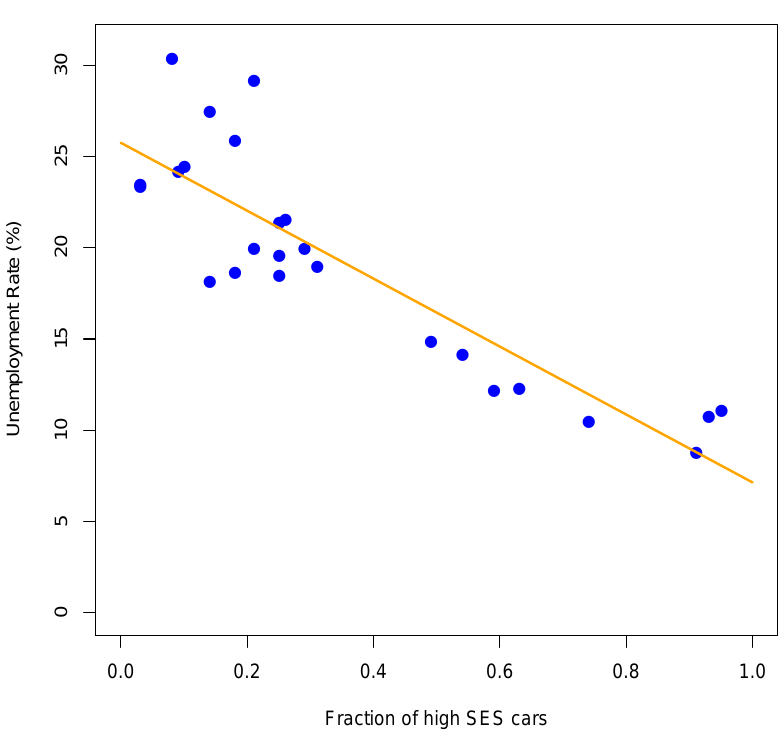
Figure 4. Linear model used to predict the local unemployment rate from the surrogate variable. Dots correspond to the actual unemployment rates of 25 Greek municipalities. SES: Socio-Economic